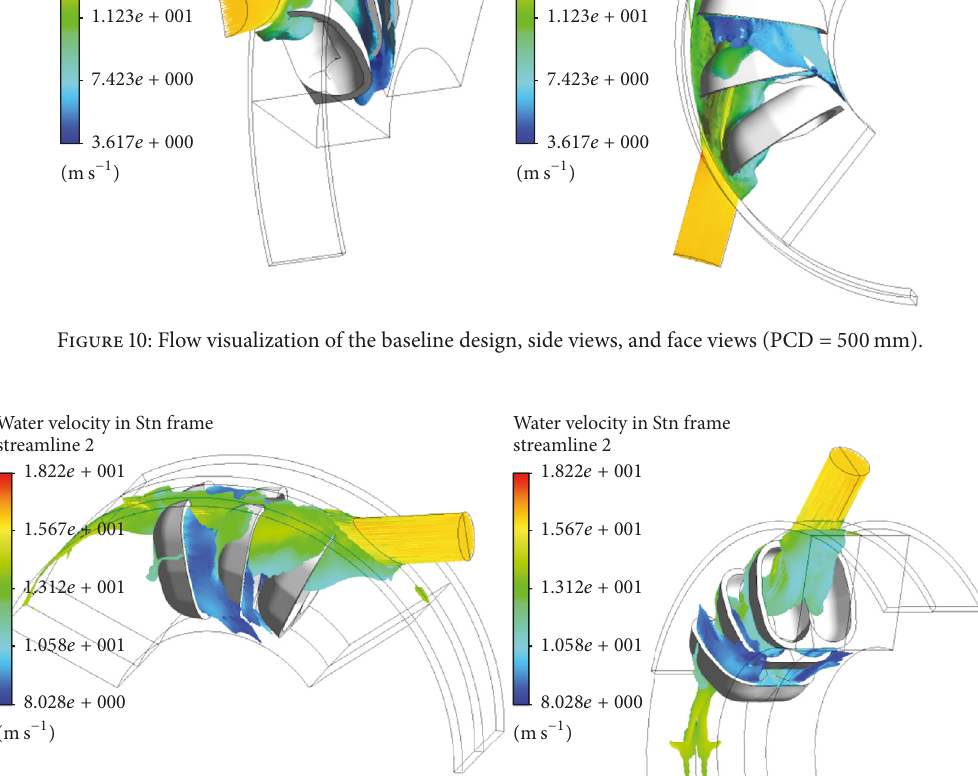
turbine installed in Khimti Hydropower in Nepal [10] and the National Technical University of Athens [19],